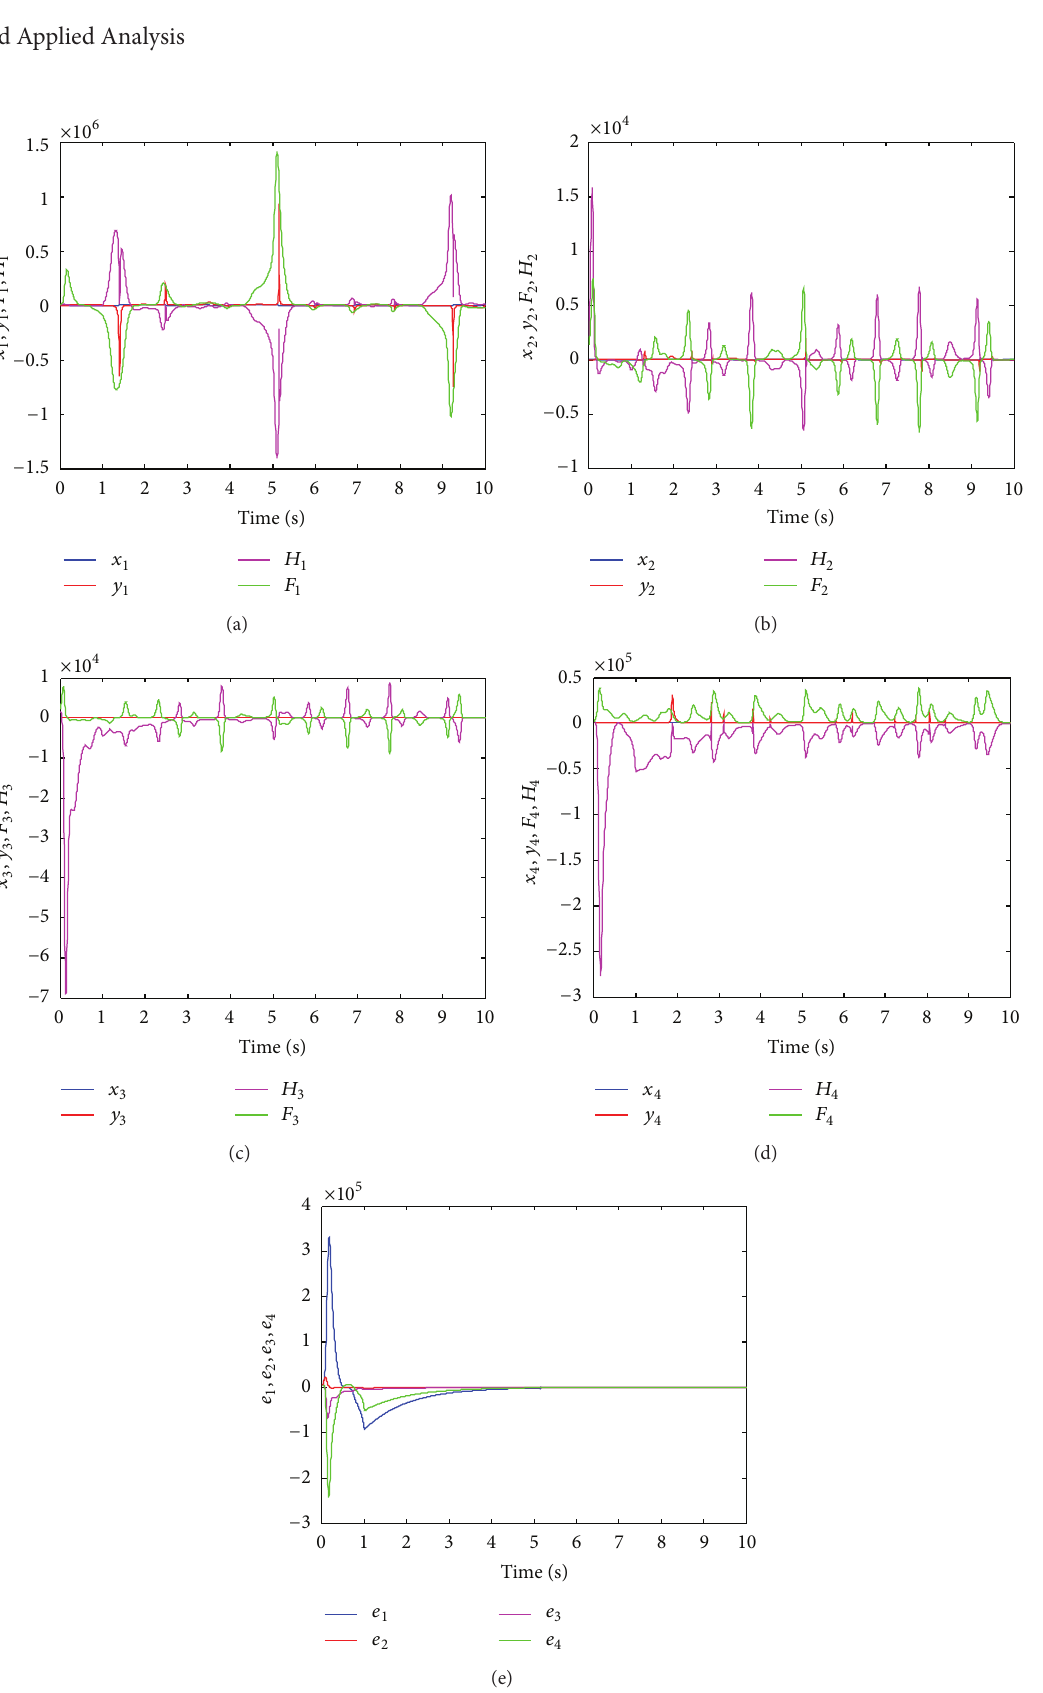
Figure 8: Time histories of states, state errors, 𝐹 1 , 𝐹 2 , 𝐹 3 , 𝐹 4 , 𝐻 1 , 𝐻 2 , 𝐻 3 , and 𝐻 4 for Case